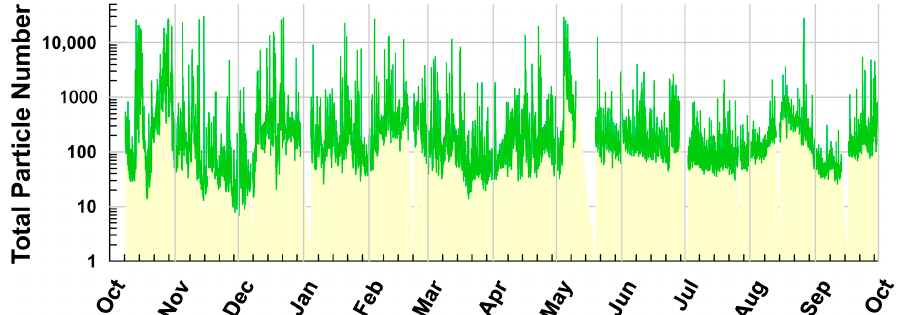
Figure 9. Time evolution of total particle number 2020/2021.